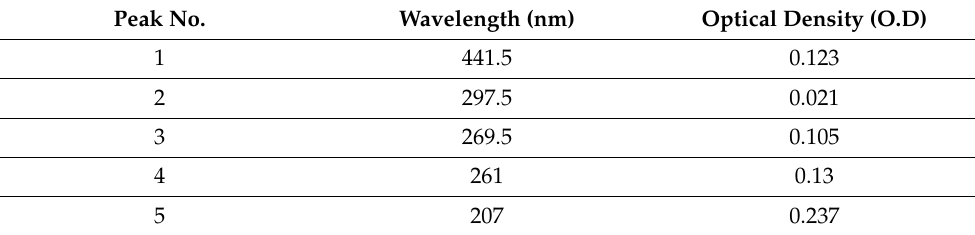
Figure 3. Ultraviolet-visible spectra verified the formation of A. platensis nanoparticles. Table 2. UV-visible spectrum of methanolic extract of A. platensis nanoparticles. Peak